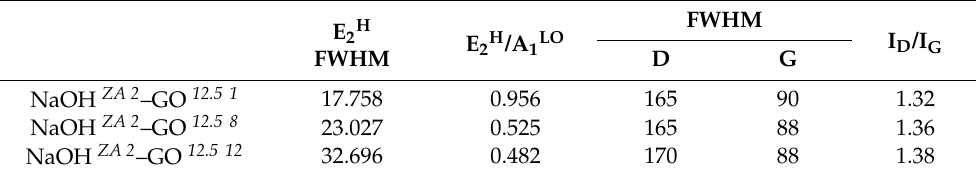
Figure 8. XRD ( a ), FTIR ( b ), and Raman ( c ) results of ZnO–rGO composites varying the pH of GO suspension to 1 (NaOH ZA 2 –GO 12.5 1 ), 8 (NaOH ZA 2 –GO 12.5 8 ), and 12 (NaOH ZA 2 –GO 12.5 12 ). Table 4. Raman data related with the modes of ZnO and rGO of ZnO–rGO composites varying the pH of GO suspension to 1 (NaOH ZA 2 –GO 12.5 1 ), 8 (NaOH ZA 2 –GO 12.5 8 ), and 12 (NaOH ZA 2 –GO 12.5 12